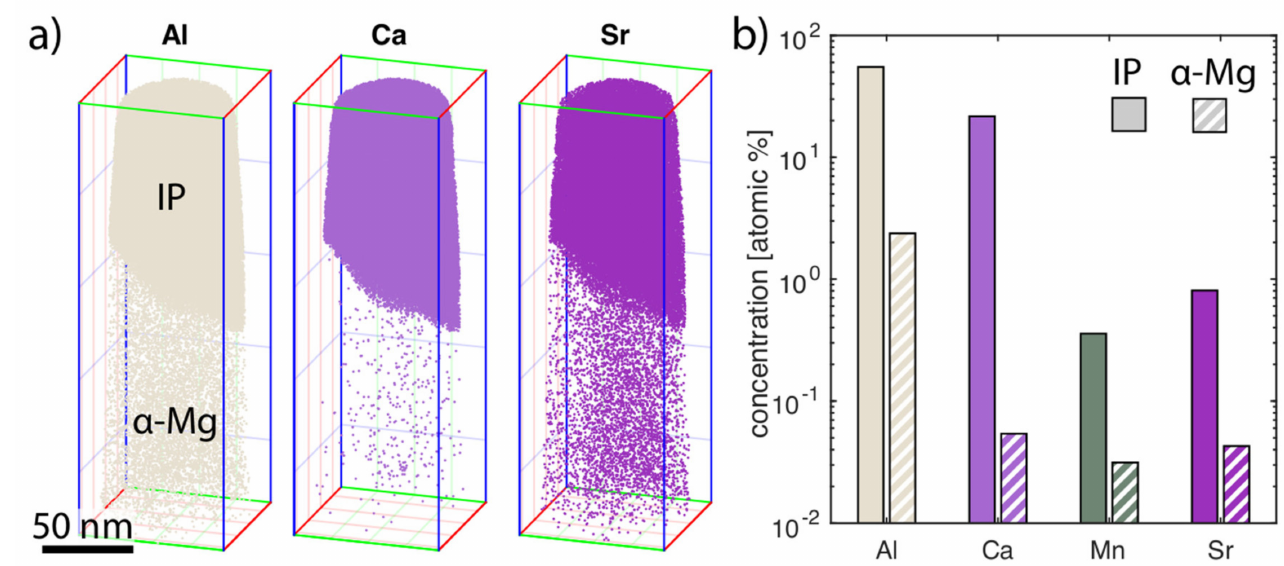
Figure 6. APT measurement results of a sample of the alloy MRI 230D after creep deformation at 200 ◦ C and a stress of 100 MPa for about 250h; ( a ) showing the Al, Ca and Sr atoms in the APT tip with the IP in the upper part and the α -Mg on the lower part; ( b ) showing the concentration of Al, Ca, Mn and Sr in the α -Mg and the